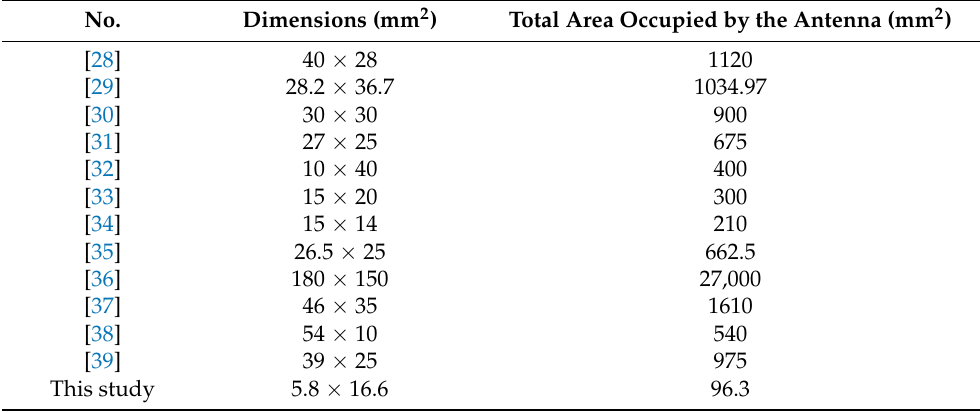
Table 2. Comparison of antenna dimensions for WLAN